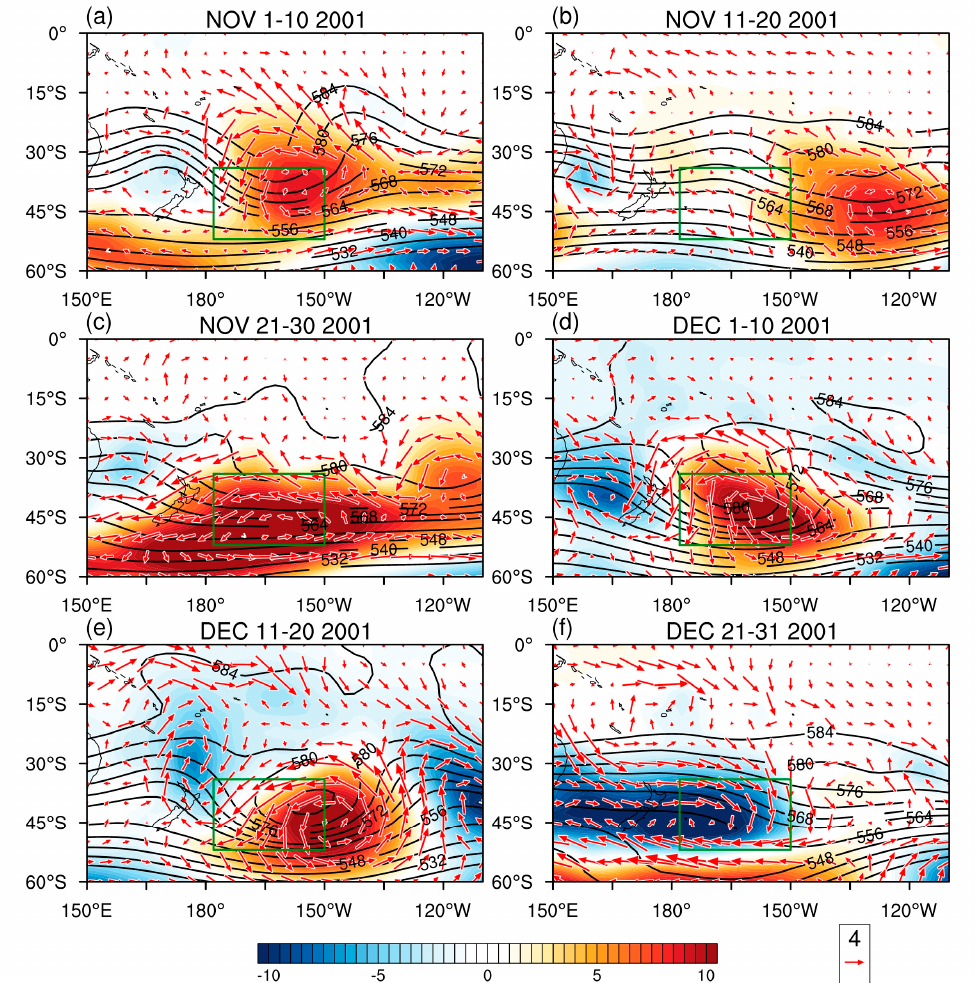
Figure 6. Same as Figure 3, but for 2001 case.